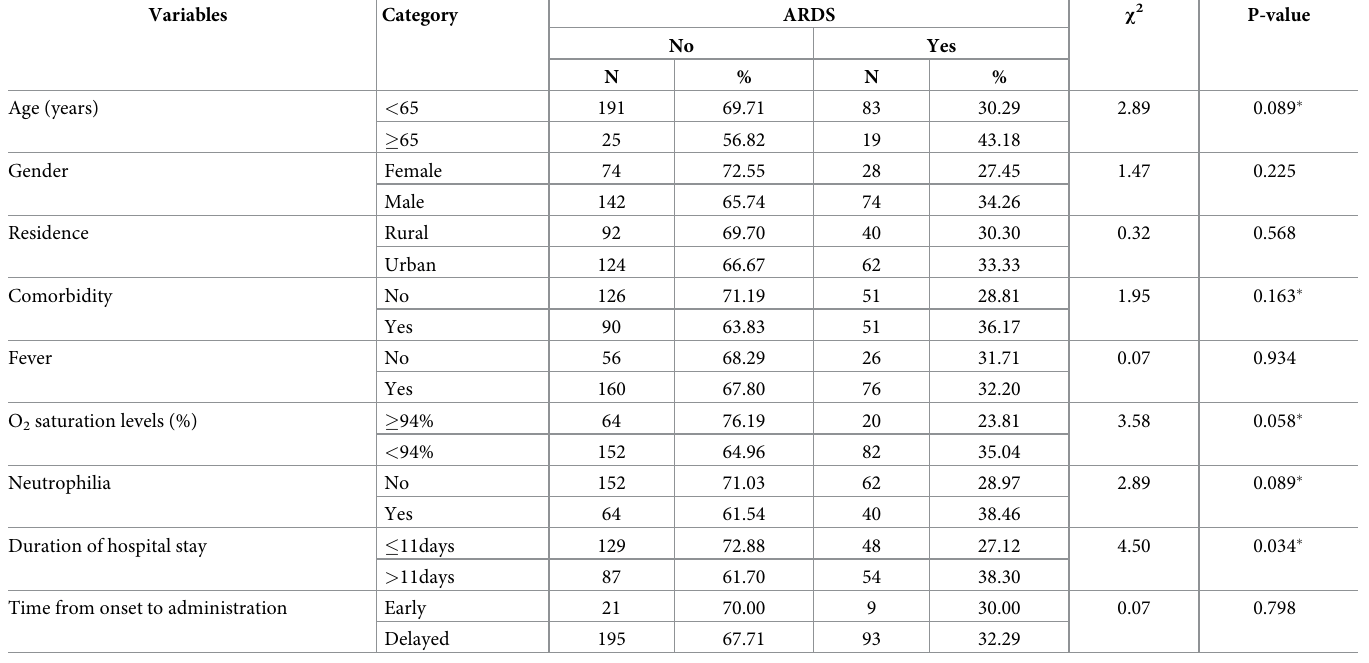
Table 3. Bivariate analysis for acute respiratory distress syndrome among patients admitted with severe COVID-19 at WURH, 2021.